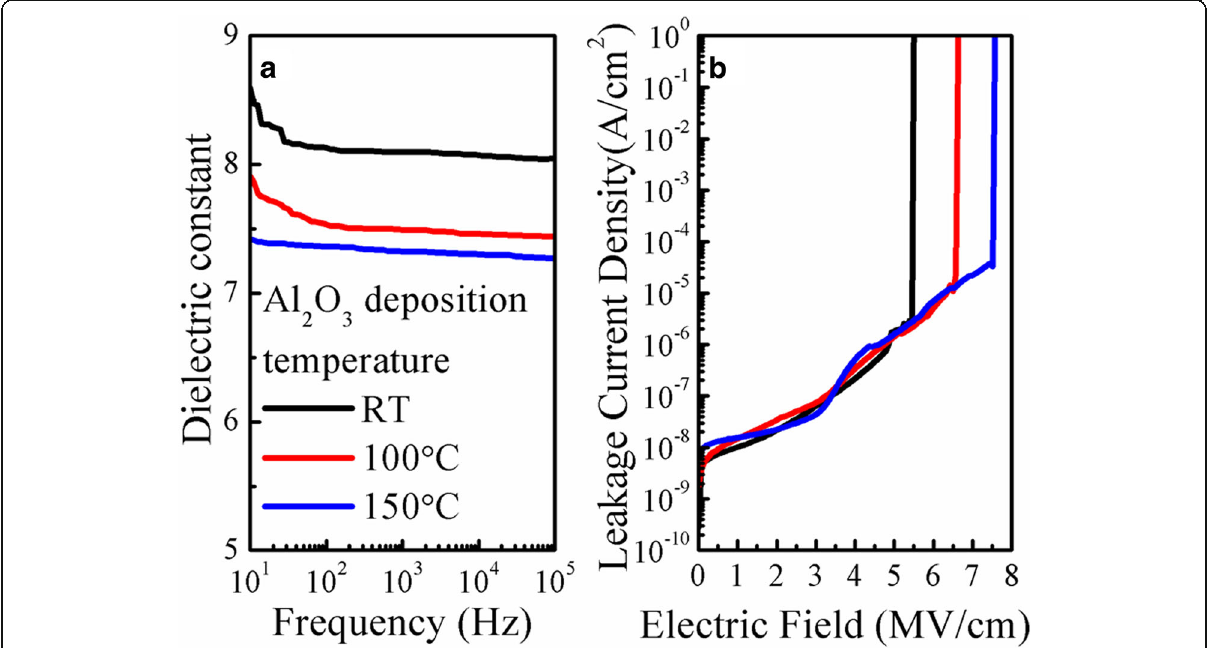
Fig. 1 Electrical properties of Al 2 O 3 films deposited at different temperatures. a Dielectric constant versus frequency. b Leakage current density versus electric